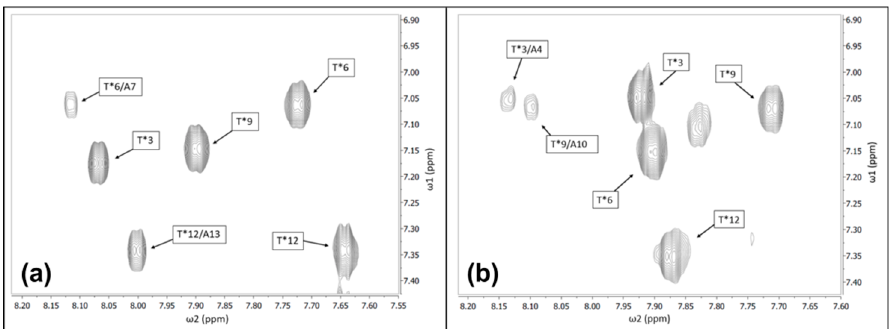
Figure 2. Characteristic nuclear Overhauser effect (NOE) between the backbone and side chain of Thr*. ( a ) AFGP8-BS and ( b ) AFGP8-TB 600-MHz 2D NOESY spectra focusing on the amide of the backbone to the amide of the disaccharide NOE correlation. The positions of the disaccharides and the threonine residues they were bonded to in the primary sequence are numbered in the black boxes.